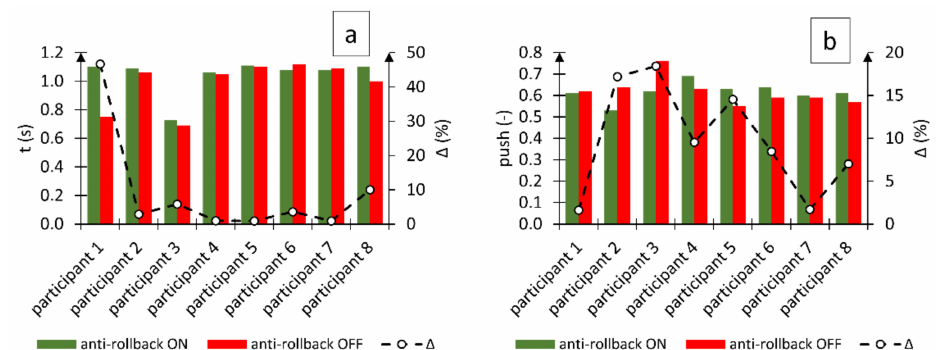
Figure 9. The diagrams of ( a ) the average values of the propelling cycle duration time and ( b ) the push phase share in the propelling cycle for respective participants with the activated anti-rollback system (anti-rollback ON) and the deactivated anti-rollback system (anti-rollback system OFF). Where: ∆ —a percentage di ff erence between the parameter measured with the activated anti-rollback-system and with the deactivated anti-rollback-system.